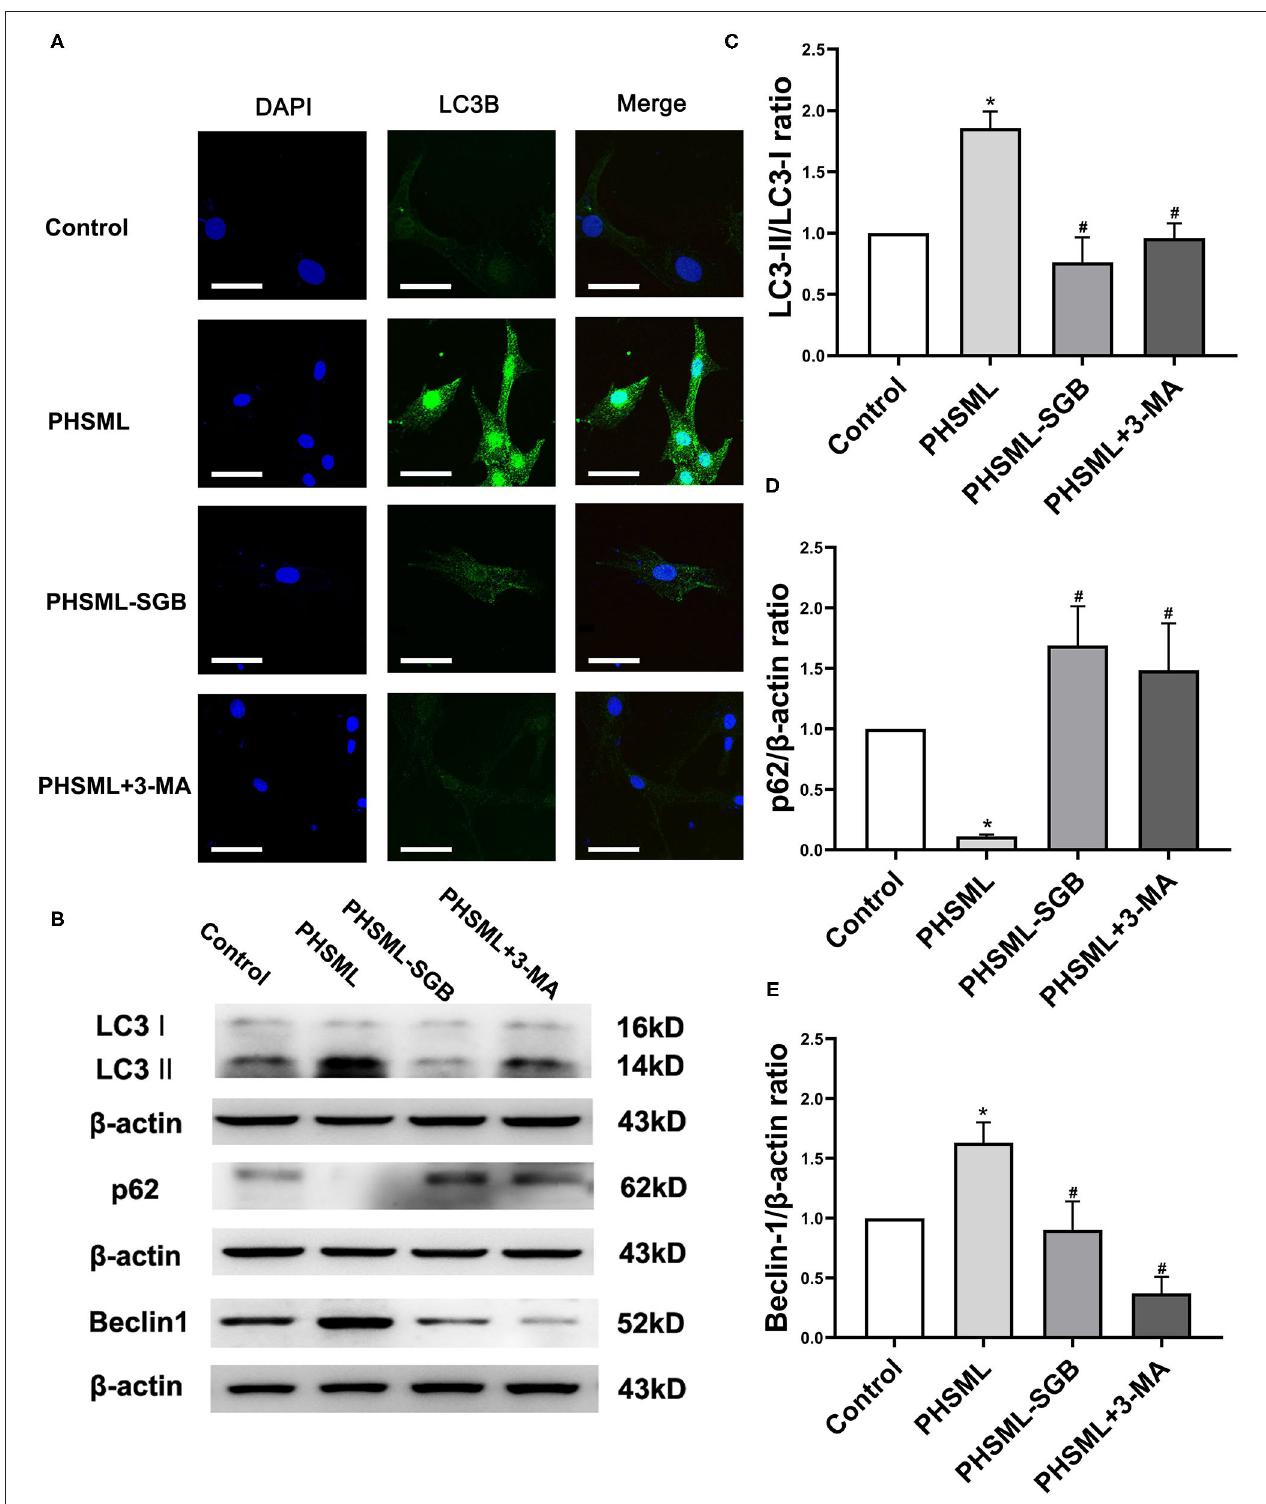
FIGURE 5 | Effects of SGB on PHSML-induced expressions of autophagy proteins in VSMCs. The cells were treated with PHSML, PHSML-SGB (PHSML obtained from the rats underwent hemorrhagic shock plus SGB treatment), and PHSML plus 3-MA (autophagy inhibitor, 5mM) for 6h, respectively. (A) The representativeness images of the localization and expression of LC3B protein in VSMCs under an Olympus laser confocal microscope. Bar = 50 µ m. (B) The representativeness images